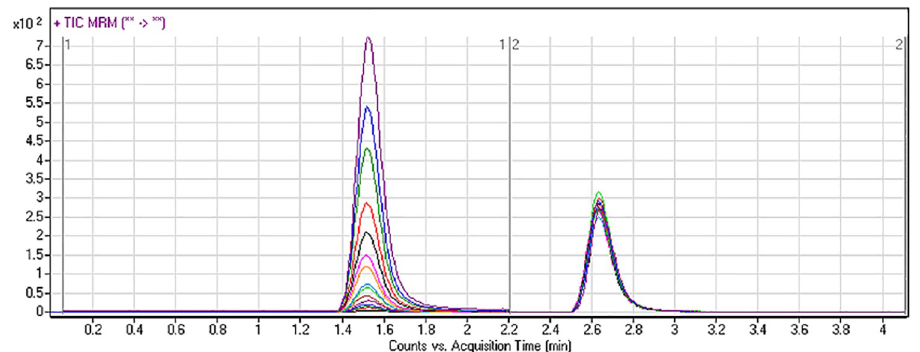
Fig 3. Overlaid MRM chromatograms of fifteen calibration standards of DMB (2–500 ng/mL) and IS (100 ng/ mL).